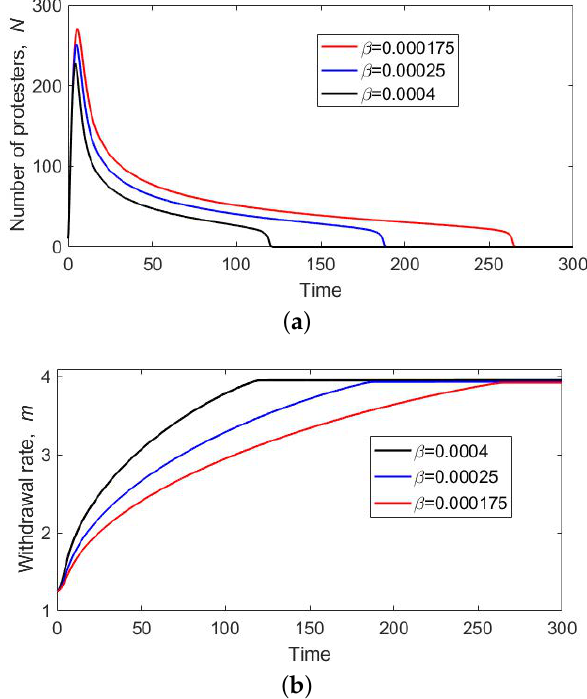
Figure 4. Solutions of Model (7) obtained for different values of β : ( a ) the number of protesters N vs. time and ( b ) the per capita withdrawal rate m vs. time. Other parameters are (cid:101) 0 = 0.1, (cid:101) = 3, a = 115, and h =